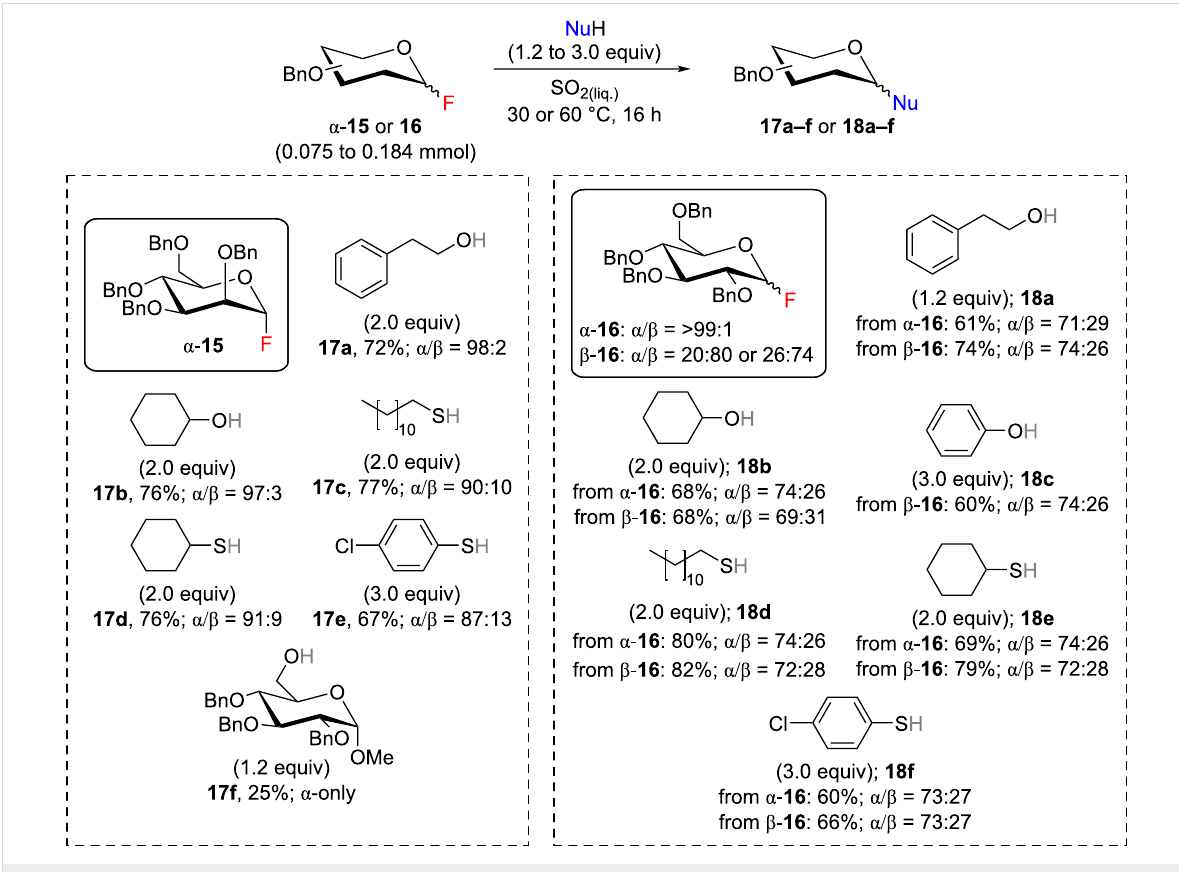
Scheme 4: Benzyl protected manno- and glucopyranosyl fluorides α - 15 and 16 as glycosyl donors in liquid SO 2 . Reactions were carried out at 30 °C for mannosyl fluoride α - 15 and glucosyl fluoride α - 16 ; at 60 °C for glucosyl fluoride β - 16 . Anomeric ratios were determined by HPLC analysis.